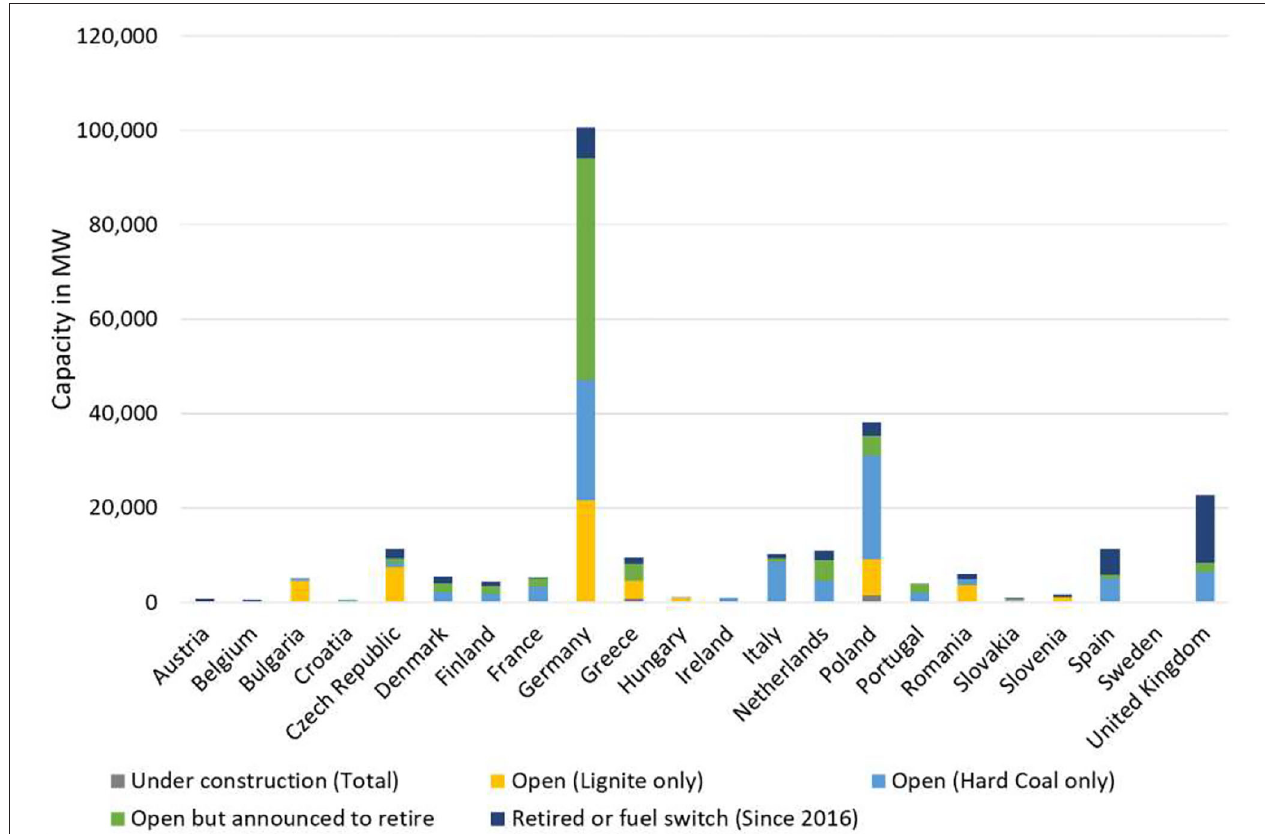
FIGURE 4 | Coal Fired plants in EU for 2019 (source: Europe Beyond Coal,